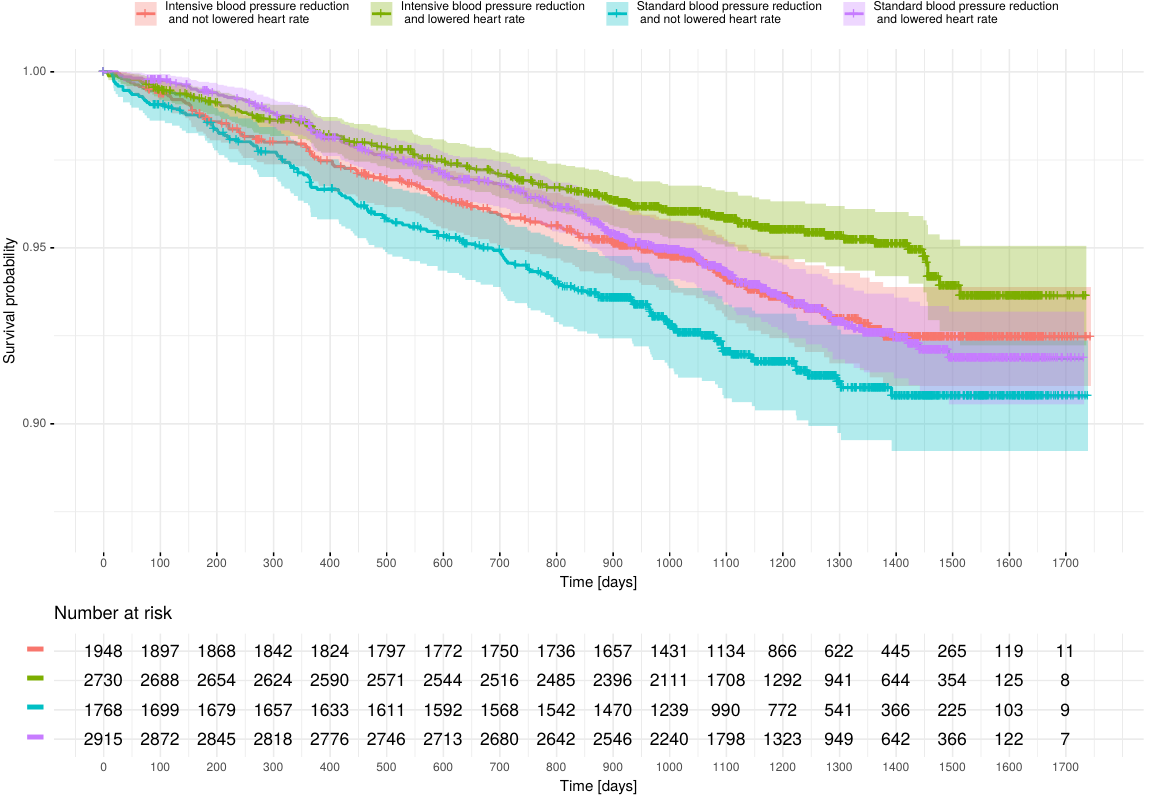
Figure 4. Kaplan–Meier curves presenting clinical-endpoint-free survival according to the study intervention arm and in-trial heart rate in relation to baseline heart rate. In subjects allocated to the intensive treatment arm, survival was highlighted using red (if in-trial heart rate was not lower than that at baseline) or green (if in-trial heart rate was lower than that at baseline) color. In subjects allocated to the standard treatment arm, survival was highlighted using blue (if in-trial heart rate was not lower than that at baseline) or violet (if in-trial heart rate was lower than that at baseline)